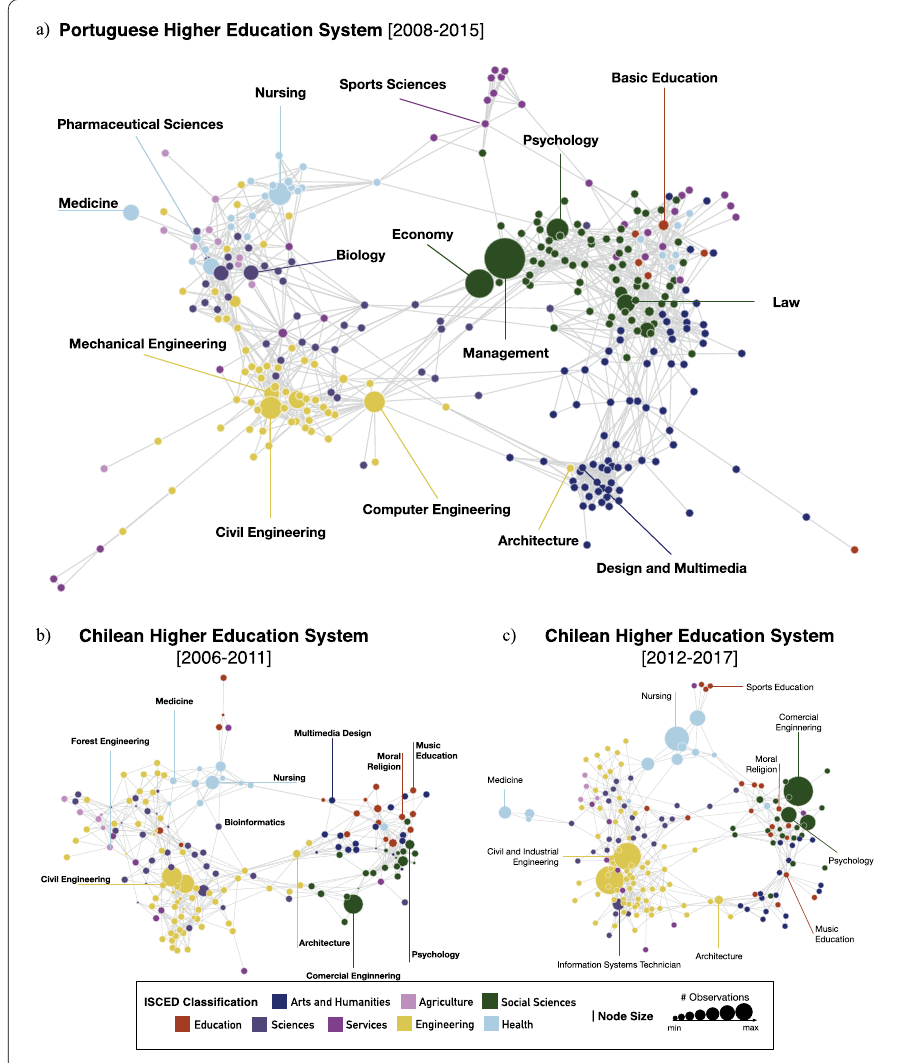
Figure 1 The HigherEducationSpace for ( a ) Portugal, from 2008 to 2015 and for Chile, for ( b ) 2006 to 2011 and ( c ) 2012 to 2017. Following the 2012’ addition of 9 new universities, the Chilean HE system was divided into two distinct networks (see Additional file 1). The color of the nodes identifies the Education Field of the degree program according to the first level of the International Standard Classification of Education (ISCED). Sizes of nodes illustrate the relative number of observations in relation to other degree programs in the same network, sizes of nodes are not comparable among different networks. Network layouts have been obtained using the SpringElectricalEmbedding algorithm implemented in Wolfram Mathematica